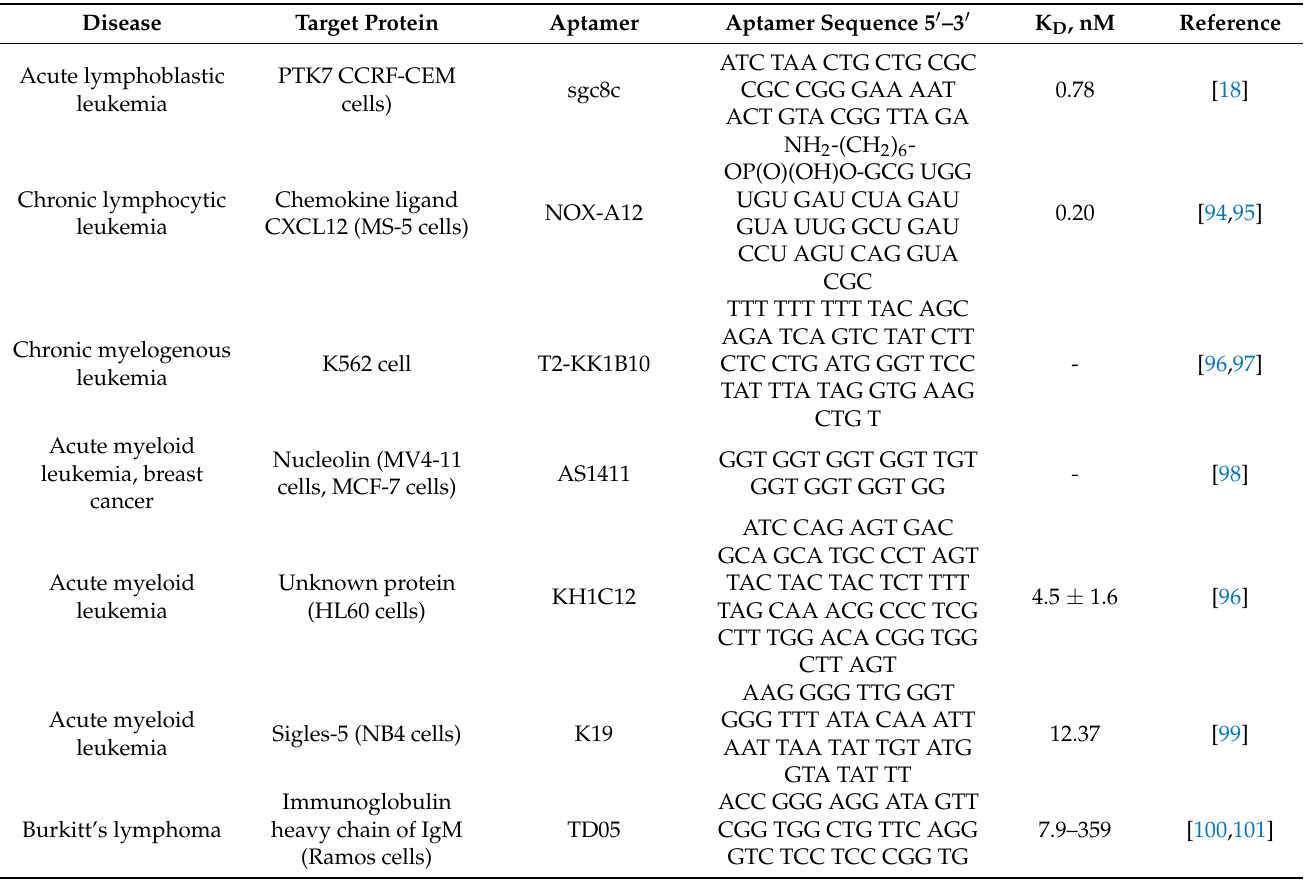
Table 2. Aptamers to various types of